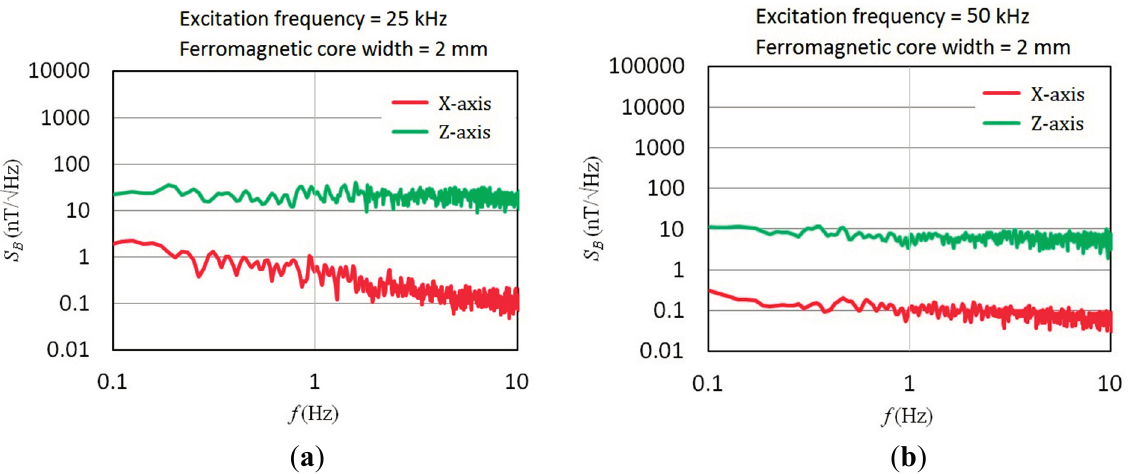
Figure 11. Field noise spectra of the magnetometer with 2-mm core width under different excitation frequencies in X- and Z-axis: ( a ) at 25 kHz; ( b ) at 50